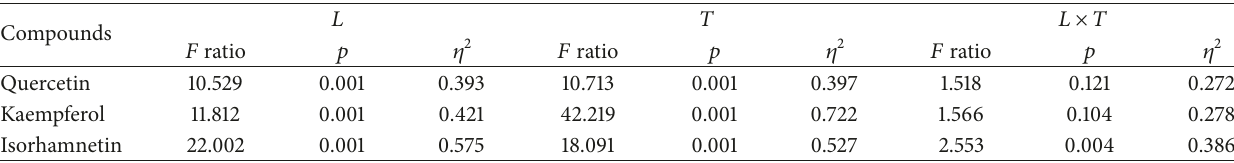
Table 4: Effect of the collection growth location, the time of harvest, and interaction between the collection growth location and the time of harvest.